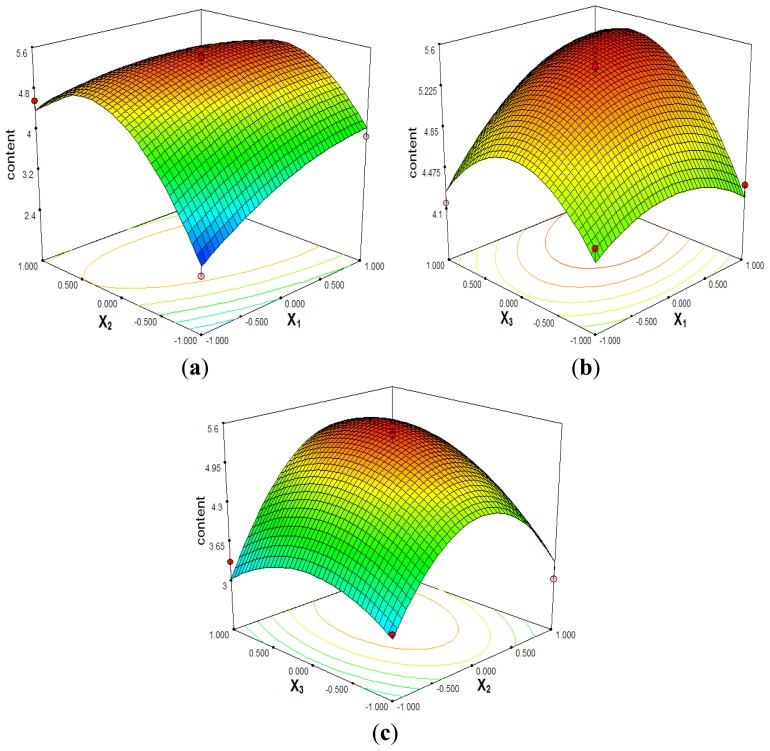
Response surface plots (3D) of reaction time, reaction temperature and ratio of Na2SeO3 to CSPS (X1: reaction time; X2: reaction temperature; X3: ratio of Na2SeO3 to CSPS).